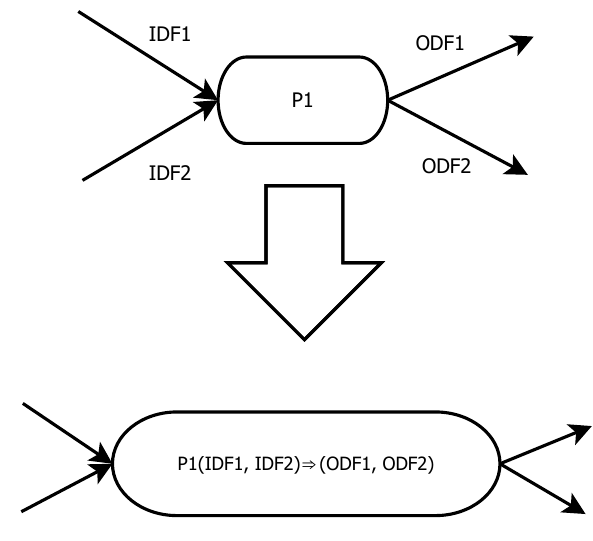
Fig. 2. Process signature